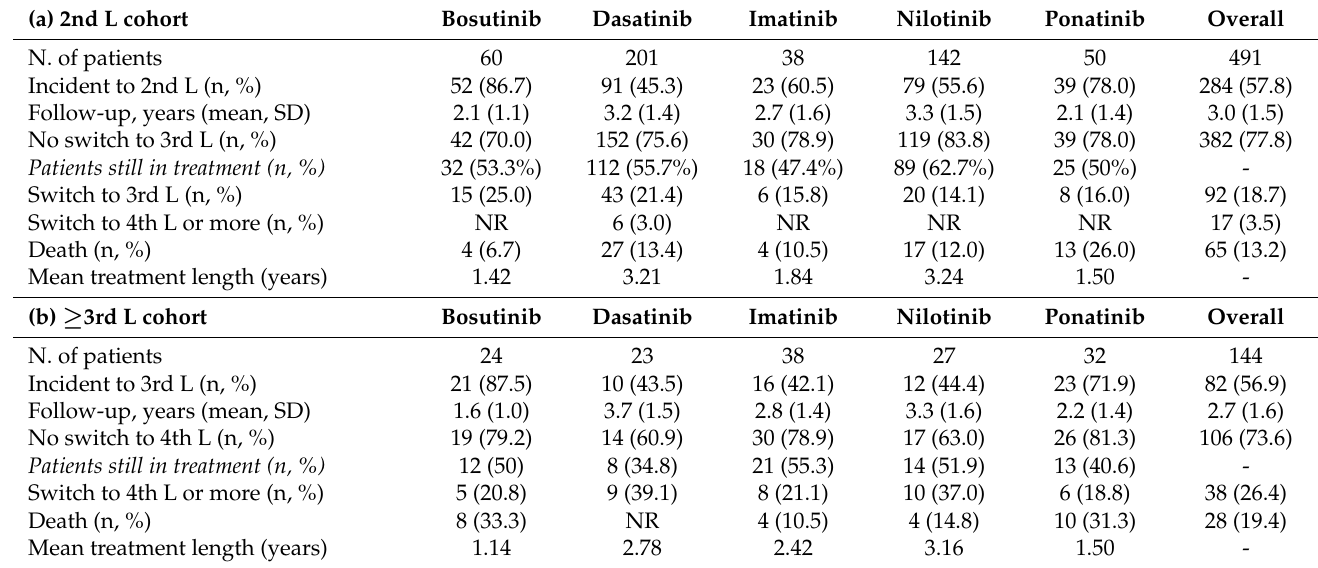
Table 3. Treatment patterns of patients in 2nd L ( a ) and ≥ 3rd L ( b ) cohorts, overall and stratified by TKI